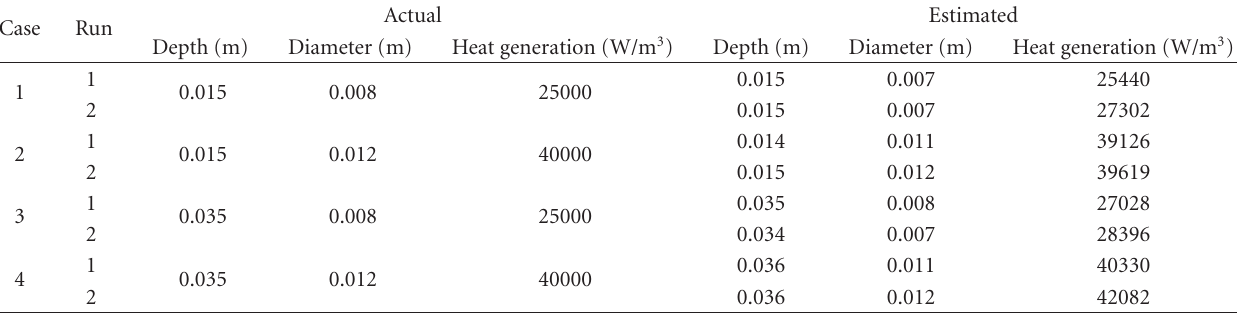
Table 3: Results from parameter estimation procedure to determine embedded tumor parameters using temperature data with 10% noise.